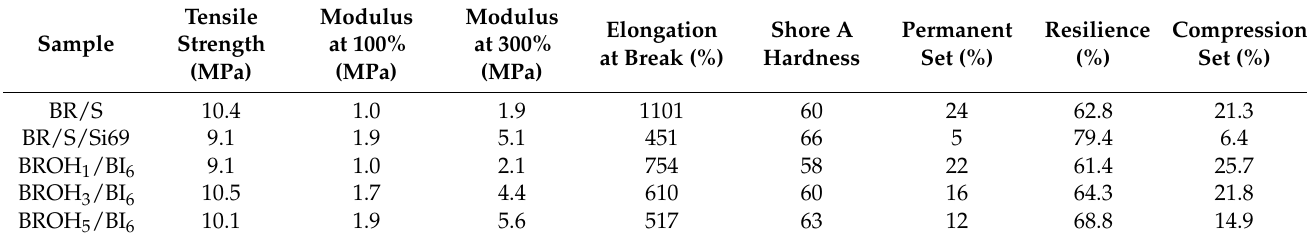
Table 1. Mechanical properties of BROH/BI/silica composites.